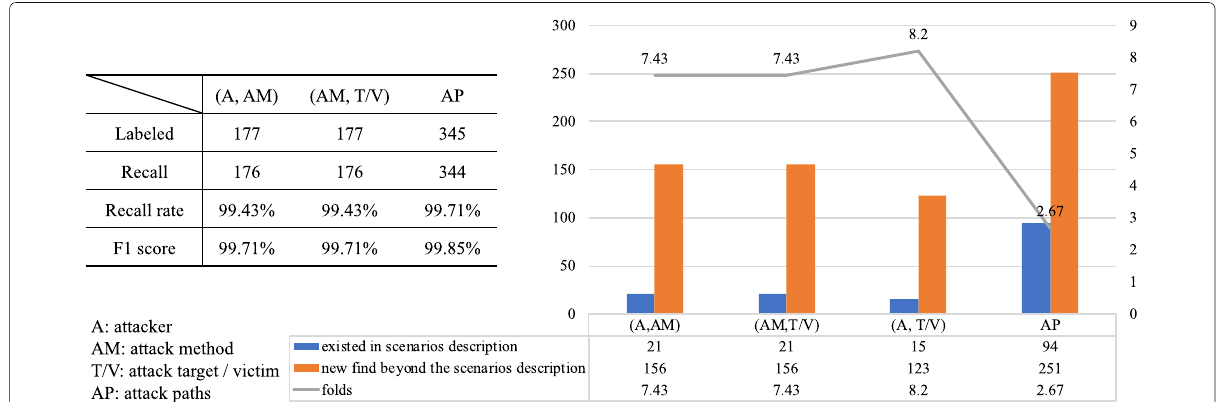
Fig. 26 Experiment results and statistic analysis of “Find additional (potential) threats for victims (targets)”, “Find potential targets for attackers” and “Find paths from specific attacker to specific target” sections